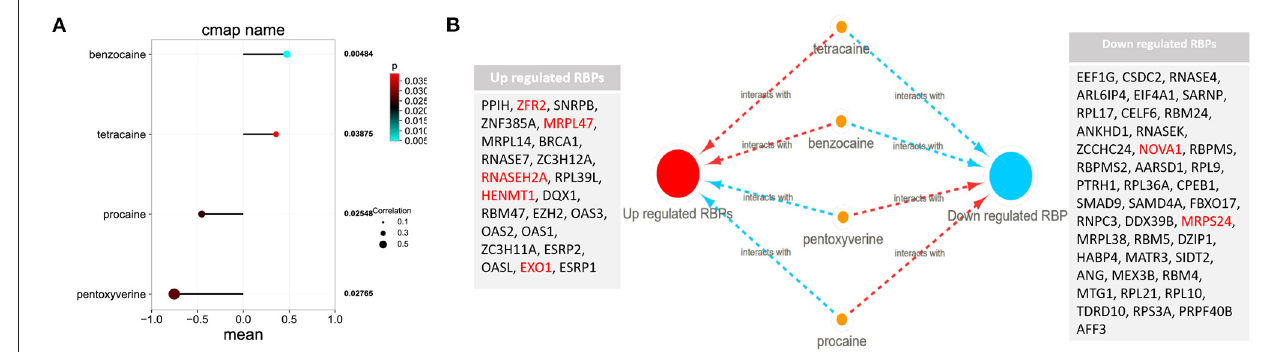
FIGURE 4 | Potential anesthetic drugs that regulate differentially expressed RBPs. (A) Regulatory relationship between narcotic drugs and differentially expressed RBPs. Mean indicates the regulatory relationship coefficient ( > 0 indicates a positive correlation with gene expression) (B) the relationship between narcotic drugs and up and down regulated RBPs. The red line represents promoting gene expression and the blue line represents inhibiting gene expression. EXO1, HENMT1, RNASEH2A, MRPL47, ZFR2, MRPS24 and NOVA1 are related to the prognosis of